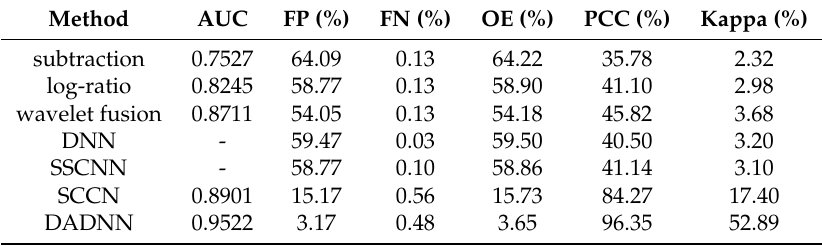
Table 5. Value of evaluation criteria of the Campbell River data set.